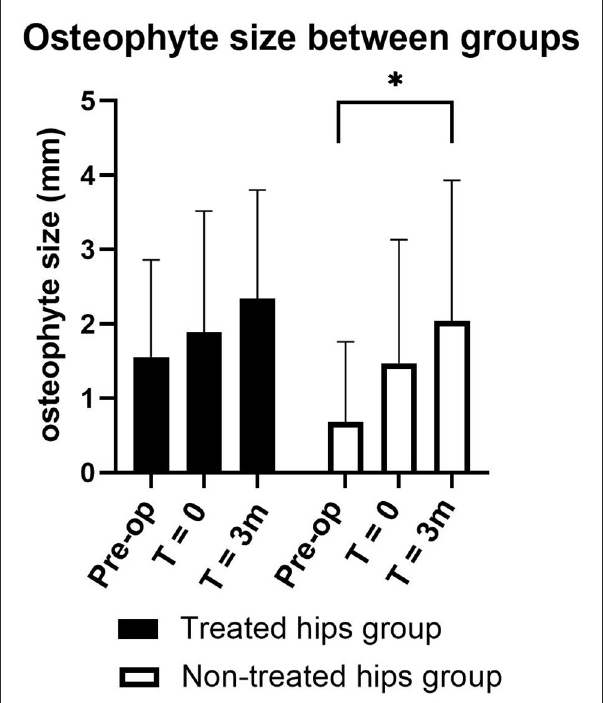
FIGURE4 Preoperative and postoperative osteophyte size compared between treated hip (black bar) and non-treated hip (white bar) group for 3 months (m) postoperative follow-up in 12 dogs with bilateral hip dysplasia that underwent unilateral acetabular rim extension surgery. Each bar represents the mean osteophyte size ± SD. * p -value < 0.05 using the Bonferroni correction for multiple